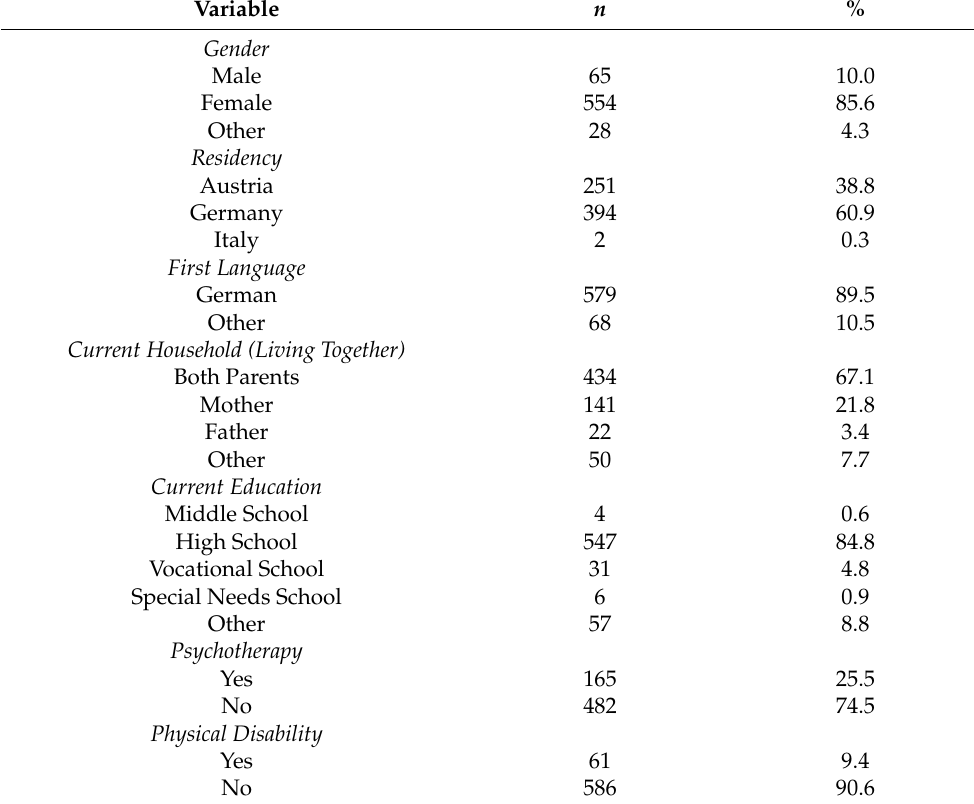
Table 1. Sociodemographic